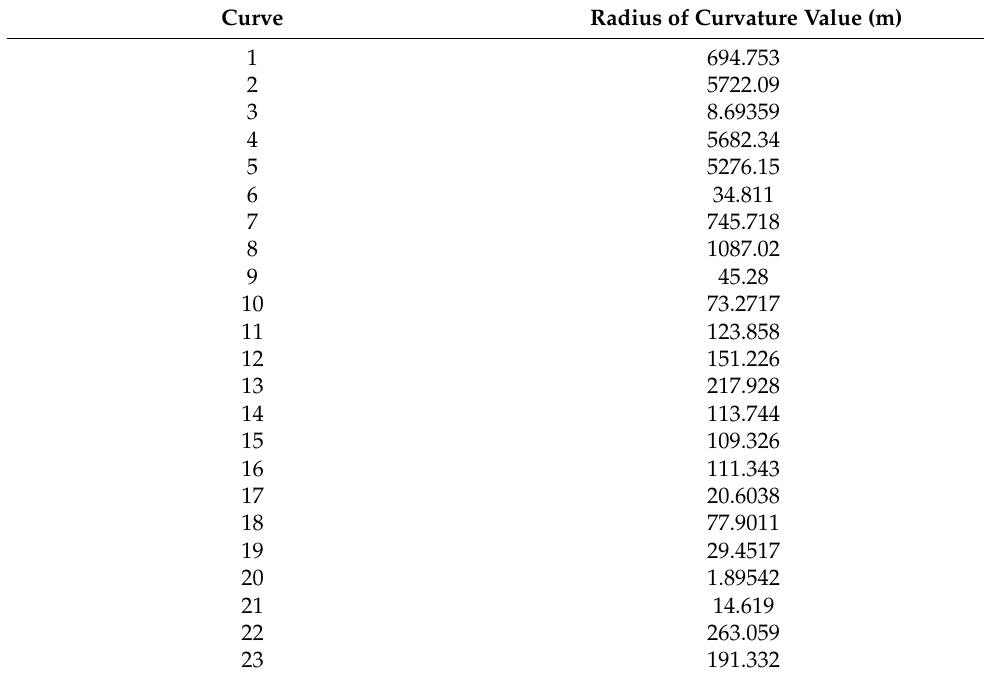
Table A7. Radius of Curvature Value.